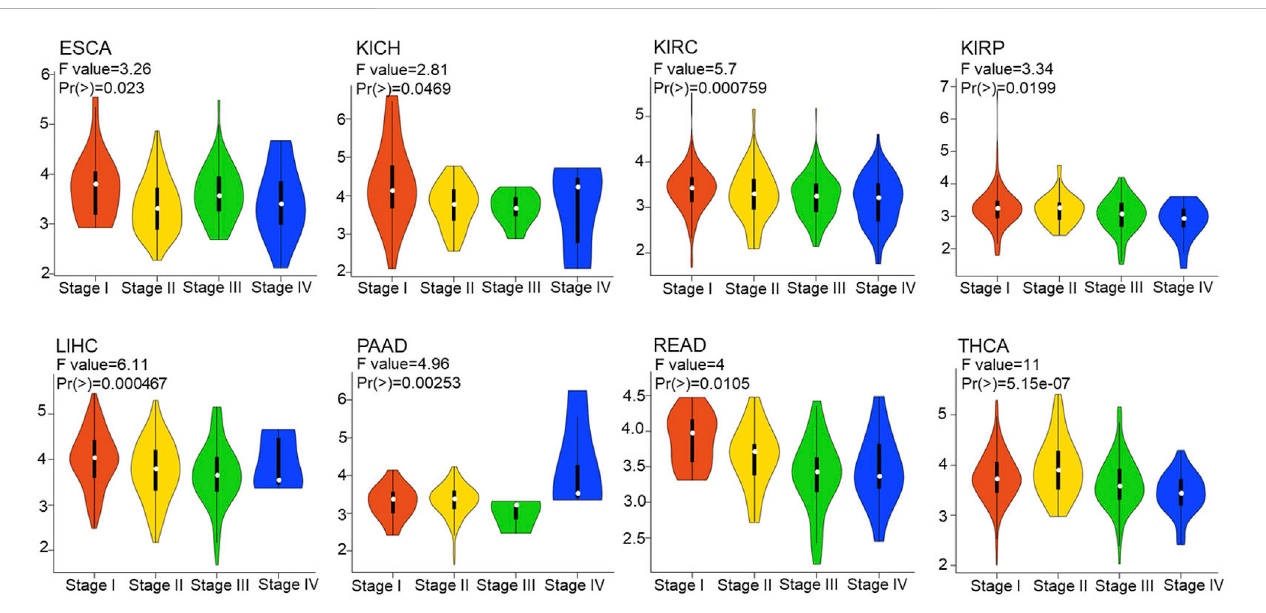
FIGURE 2 Correlation between FDX1 expression and tumor stages. The correlation between FDX1 expression and tumor stages in pan-cancer based on Gene ExpressionPro fi leInteractiveAnalysis2.0(GEPIA2.0).[onewayANOVAtest,Pr( > F) < 0.05wasconsideredsigni fi cant.ThelargertheFvalueandthesmallerthe Pr ( > F) value, the greater difference in characteristics between